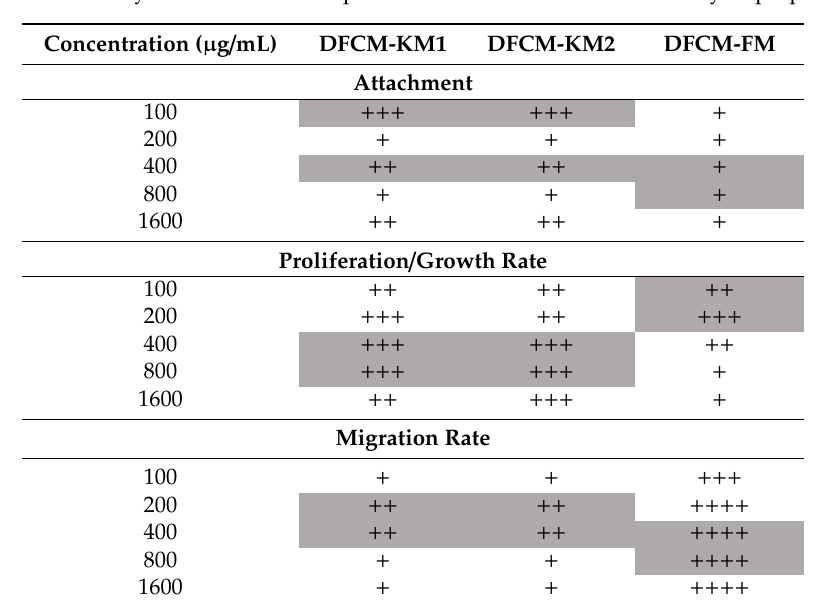
Table 1. Summary of concentration dependent e ff ect of DFCM on keratinocytes